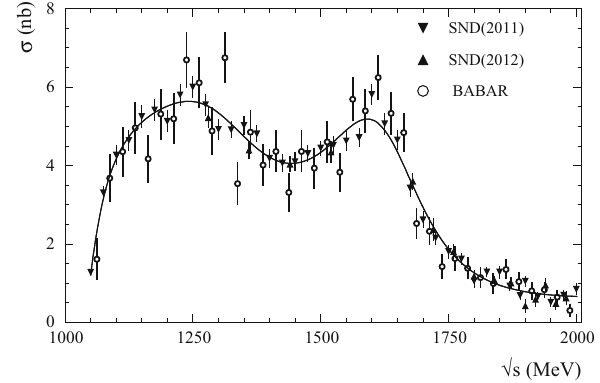
Fig. 4 The Born cross section for the process e + e − → π + π − π 0 measured in this work for 2011 and 2012 scans, in comparison with the results of the BABAR experiment [8]. The curve represents the result of the fit to the SND data with a sum of contributions from the resonances ω( 782 ) , φ( 1020 ) , ω( 1420 ) , and ω( 1650 )